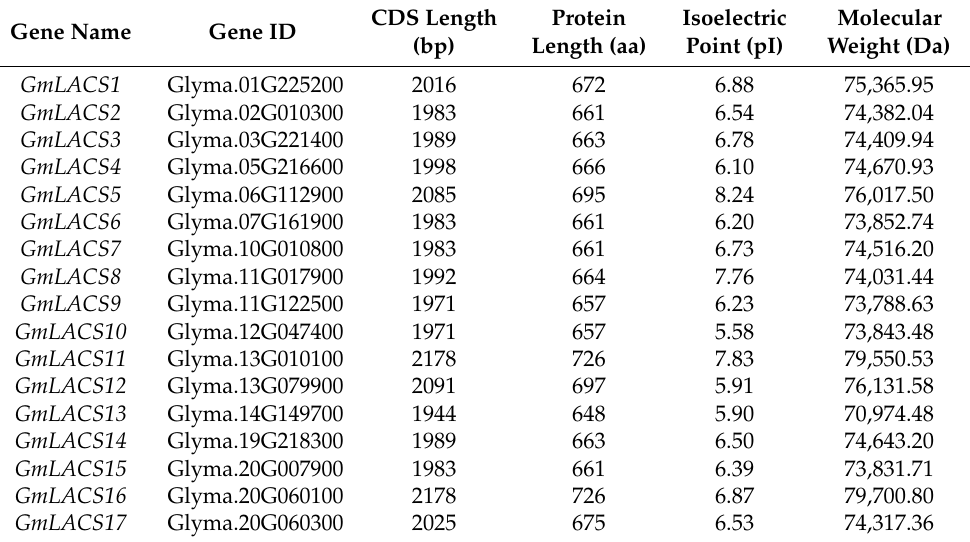
Table 1. Basic information of the seventeen soybean LACS genes ( GmLACSs